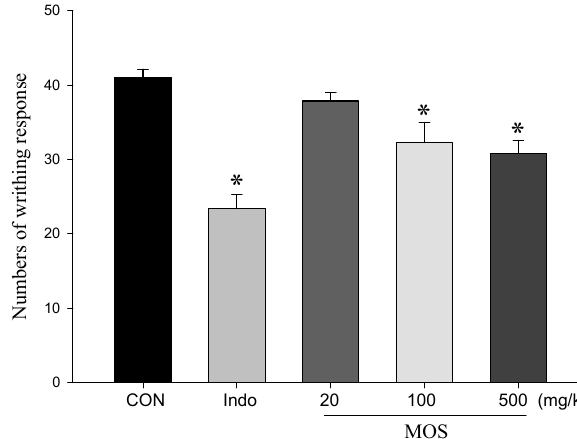
on acetic acid-induced writhing response in mice. Figure 2. Analgesic effect of MOS EtOH Indomethacin (Indo 10 mg/kg) was use as a therapeutic control. The number of muscular (20, 100 and contractions was evaluated as described in Section 2. Treatment of MOS EtOH 500 mg/kg) and Indo (10 mg/kg) showed that there was an inhibition of writhing number compared to the control. Each value represents as mean ± SEM ( n = 10). * p < 0.05 as compared with the acetic acid-treated only